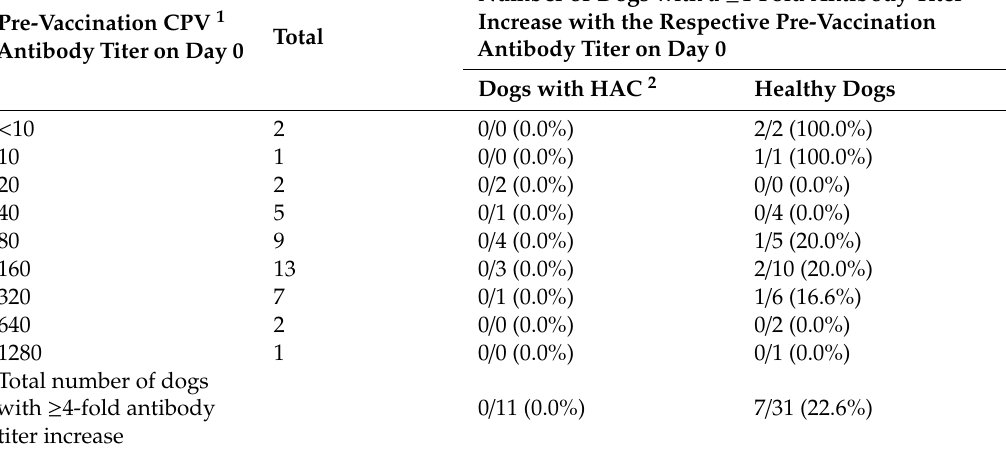
Table 3. Canine parvovirus pre-vaccination antibody titer on day 0 and number of dogs with an ≥ 4-fold titer increase during the course of the